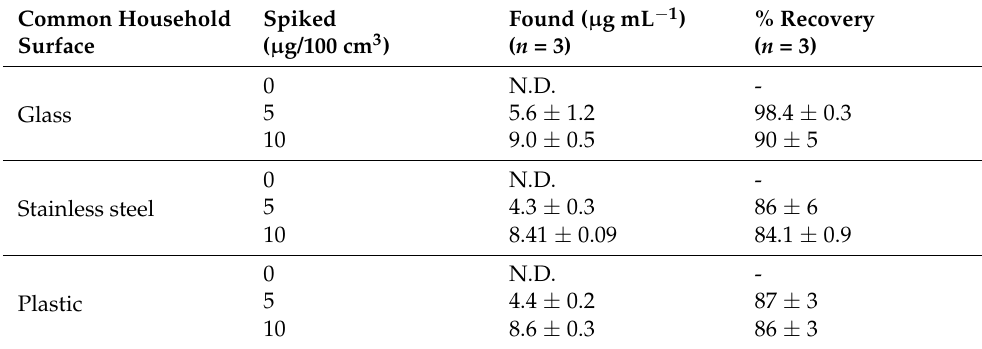
Table 1. Recoveries of MA on household surfaces including glass, stainless steel, and plastic from surface areas of 100 cm 2 .